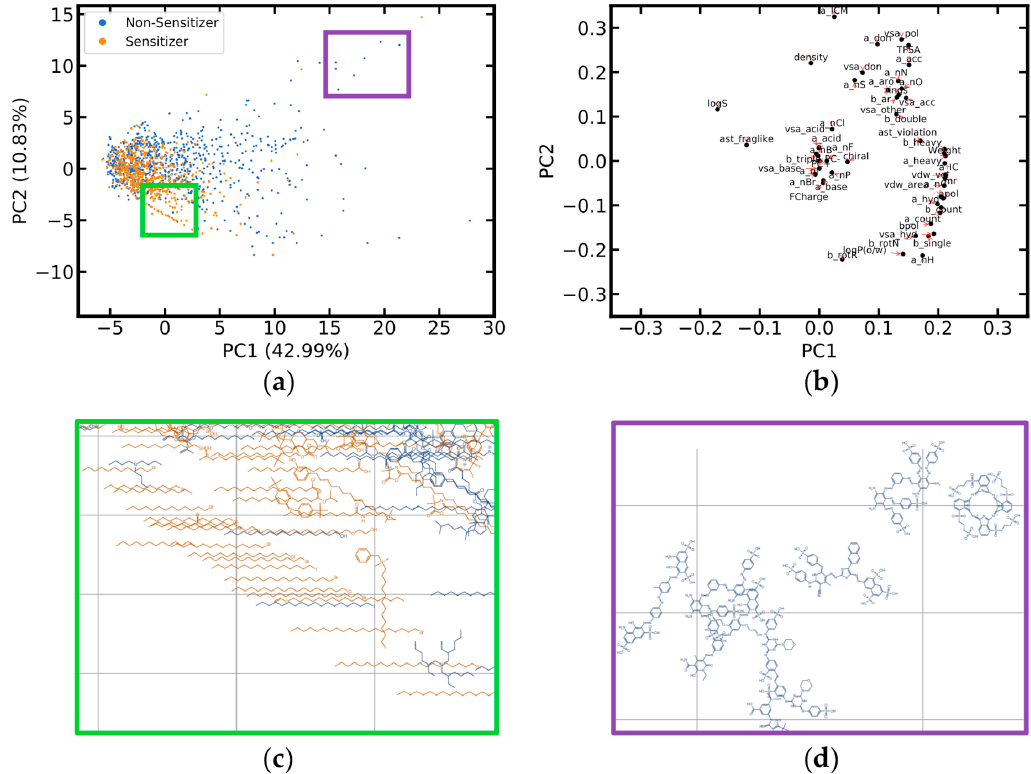
Figure 5. Principal component analysis (PCA) of the physicochemical properties of skin sensitizers and non-sensitizers included in the merged local lymph node assay (LLNA) data set. The PCA is based on the identical setup described in the caption of Figure 1. ( a ) Score plot, with the percentage of variance explained by the individual principal components reported as part of the axis labels. Two data points are located outside the displayed intervals. ( b ) Loadings plot (an enlarged version is provided in Figure S1; the abbreviations of the individual molecular descriptors are explained in Table S1). ( c ) Detailed view of the lower left region of the score plot, where mainly sensitizers are observed to form a line of data points. These sensitizers are aliphatic, monohalogenated hydrocarbons that di ff er primarily by chain length and halogen atom type. ( d ) Detailed view of the upper right part of the